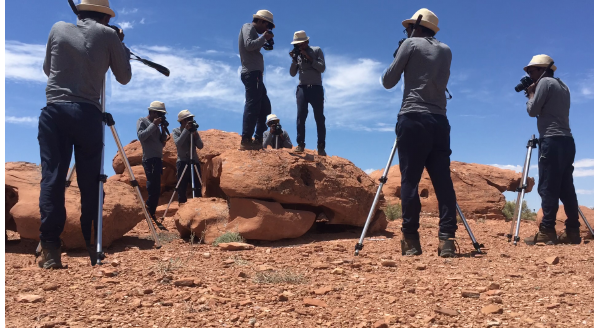
Figure 8. Multi-exposure image showing the different spatial posi- tions from which images were acquired. First, images were acquired from a distance of ∼ 2m, and then close-up images were taken from a distance of <1m. The DEM and orthophoto of the imaged boulder are shown in Fig. 10g and